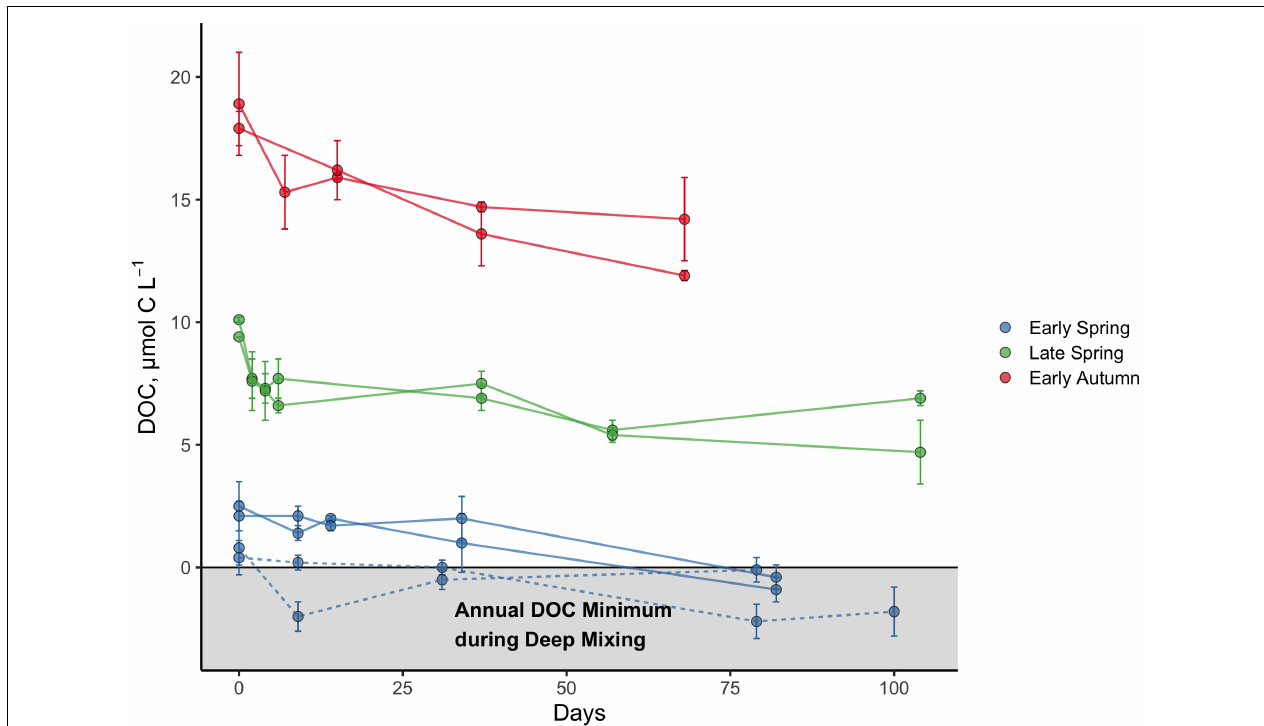
FIGURE 4 | Bioavailability and persistence of seasonally accumulated DOC (DOC SA ) at the 44 ◦ N latitudinal bin of the NAAMES study region based on DOC remineralization experiments. Experiments were conducted at two different stations corresponding to 44 ◦ N in the early spring and are denoted by the solid (station 3) and dashed lines (station 4). Data represent measurements for each incubation bottle, with error bars representing the standard deviations. The horizontal line intersecting the y -axis at 0 represents the baseline after the annual minimum DOC concentration corresponding to the maximal deep winter mixing (Baetge et al., 2020) has been subtracted from the measured surface DOC concentration for each season.